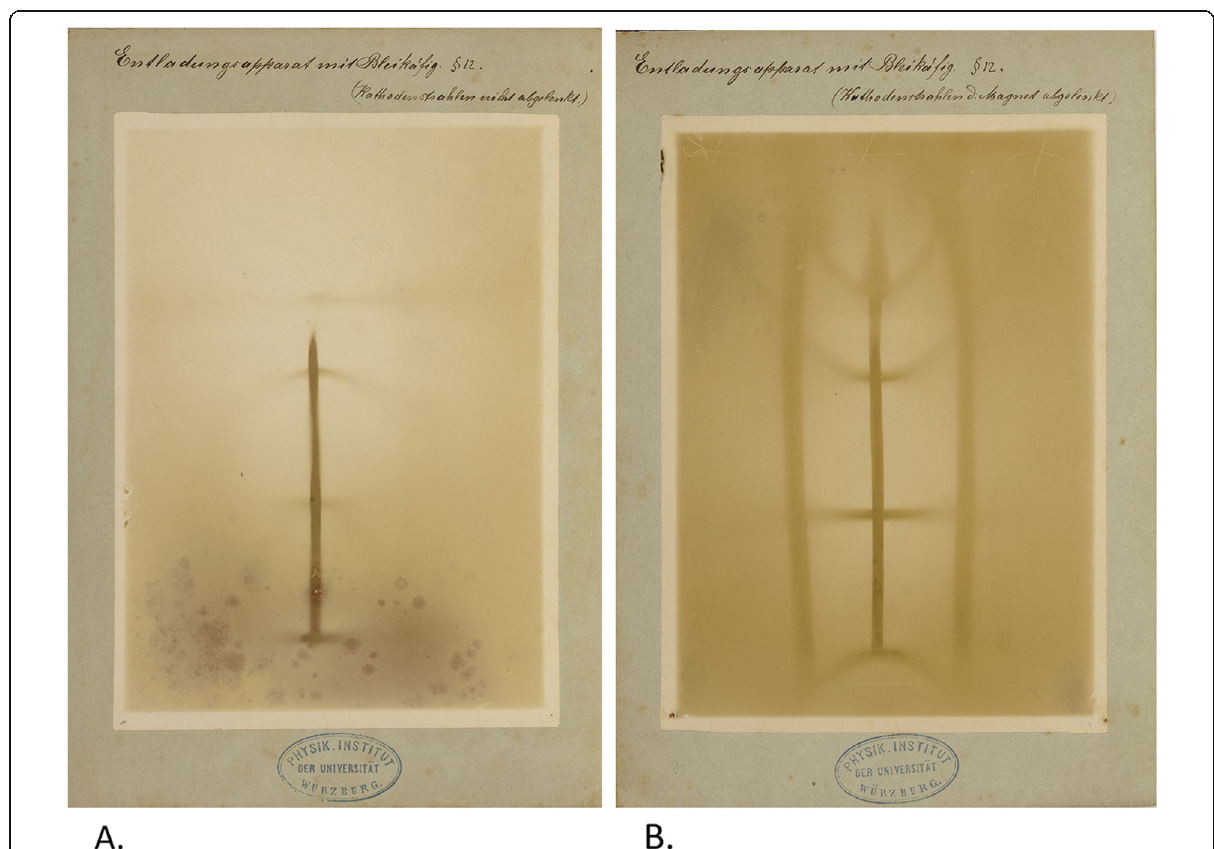
Fig. 8 a , b Two radiographic images of a leaden cage that surrounds the gas discharge tube. The difference between them is that the second image was taken while the cathode rays were deflected using a magnet while in the first image the magnet was absent. Between the two radiographs, the shadow of the leaden cage moved. Roentgen concluded from this that the X-rays had to emanate from the point on the glass wall of the discharge tube where the cathode rays impinged and this point had moved as a result of the deflection of these cathode rays. It can be noticed that the magnet pulls the focal spot downward, resulting in the central ray to hit the center of the cage (shadow of the ribs at the top of the cage bend upward and the brightest part of the background moves downward) while, at the same time, the focal spot becomes smaller (image becomes sharper). Respective manually written legends: ‘ Entladungsapparat mit Bleikäfig (Kathodenstrahlen nicht abgelenkt) ’ (Gas discharge tube with leaden cage (cathode rays not deflected)) and ‘ Entladungsapparat mit Bleikäfig (Kathodenstrahlen d[ urch ] (The word ‘ durch ’ was completed by the author) Magnet abgelenkt) ’ (Gas discharge tube with leaden cage (cathode rays deflected by a magnet)). Paragraph referral: § 12 (in both